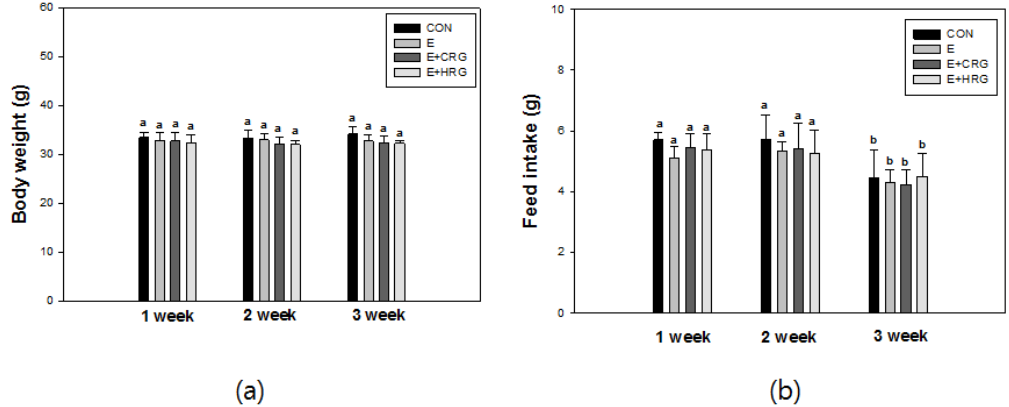
Figure 1. Changes of body weight ( a ) and food intake ( b ) in ICR mice. The results are given as the mean ± standard deviation ( n = 8). Different letters indicate statistically significant differences between means at p < 0.05. CON: no exercise group, E: high- intensity exercise group, E + CRG: high-intensity exercise group supplemented with